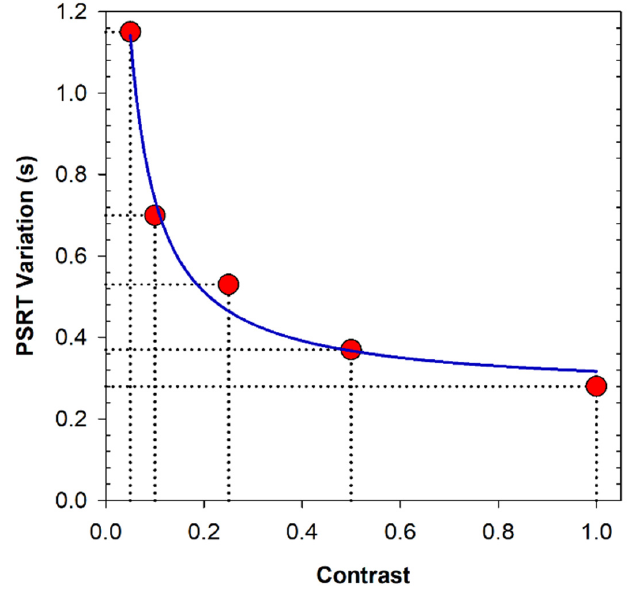
Figure 4. PSRT variation (difference mean PSRT values for all glare angles between myopic and control eyes) as a function of the stimuli contrast. The blue line represents the non-linear regression of the plotted data.